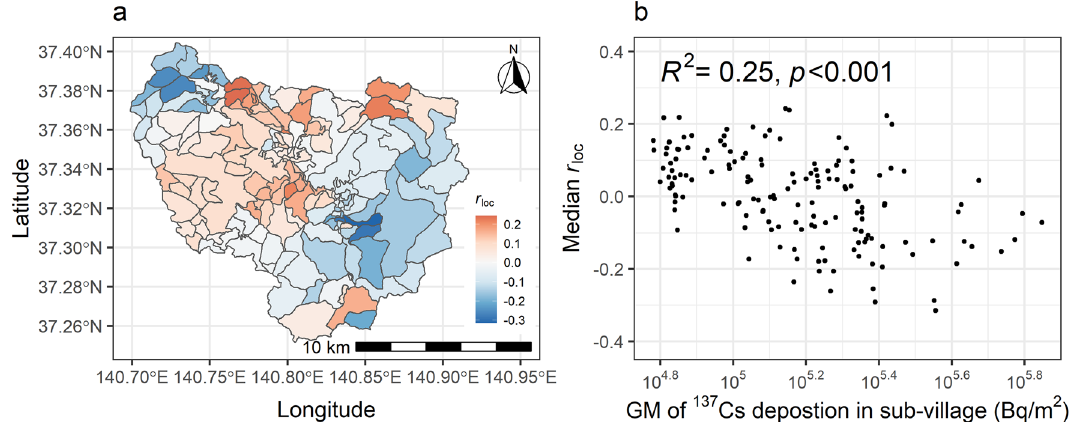
Figure 5. ( a ) The map of median posterior spatial parameter affecting on concentration ( r loc ). ( b ) Relationship between 137 Cs deposition and median r loc of each sub-village. The sub-village boundaries were created from a hand-drawn map obtained from the administrative office. The map was created using R version 4.1.0 29 and ggplot2 package 30